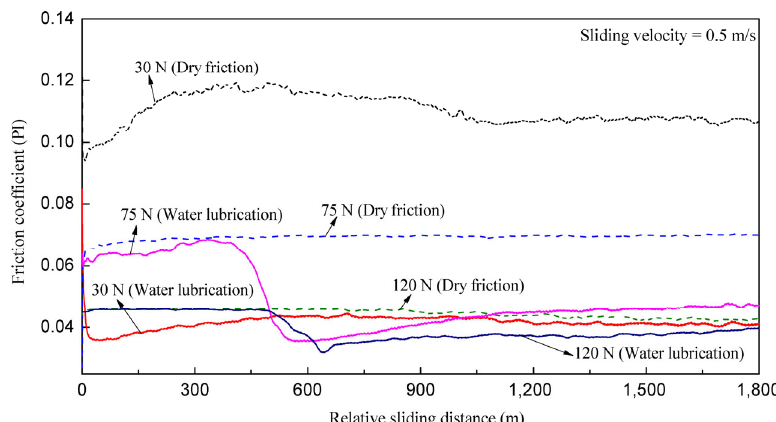
Fig. 4 Friction coefficient of PI as a function of relative sliding distance for different